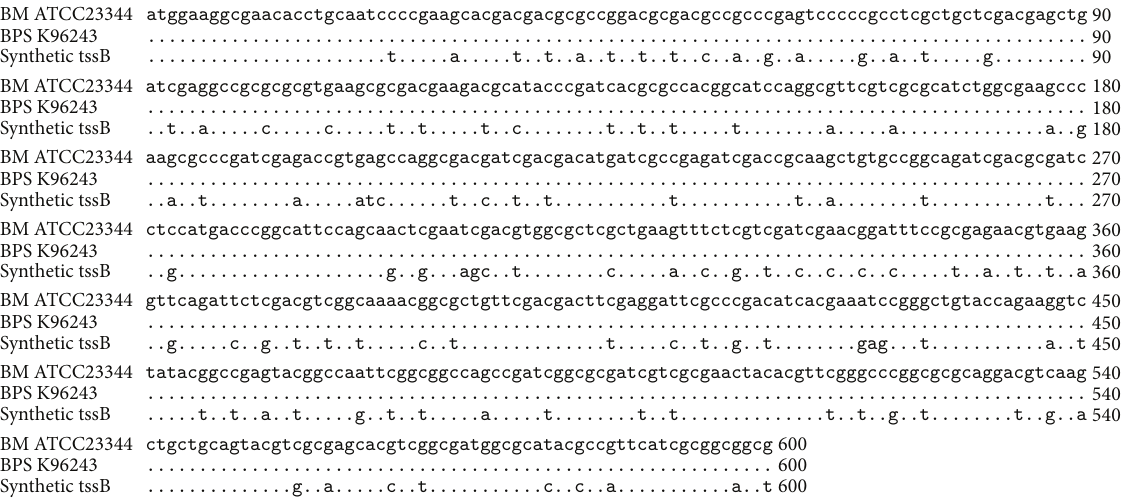
Figure 1: Sequence alignment of 5 󸀠 terminal 600bp tss B gene of B. mallei , B. pseudomallei, and customized tss B gene. Identical sequences are represented by dot. Nonidentical sequences at third base of codon have been modified during the process of codon optimization.